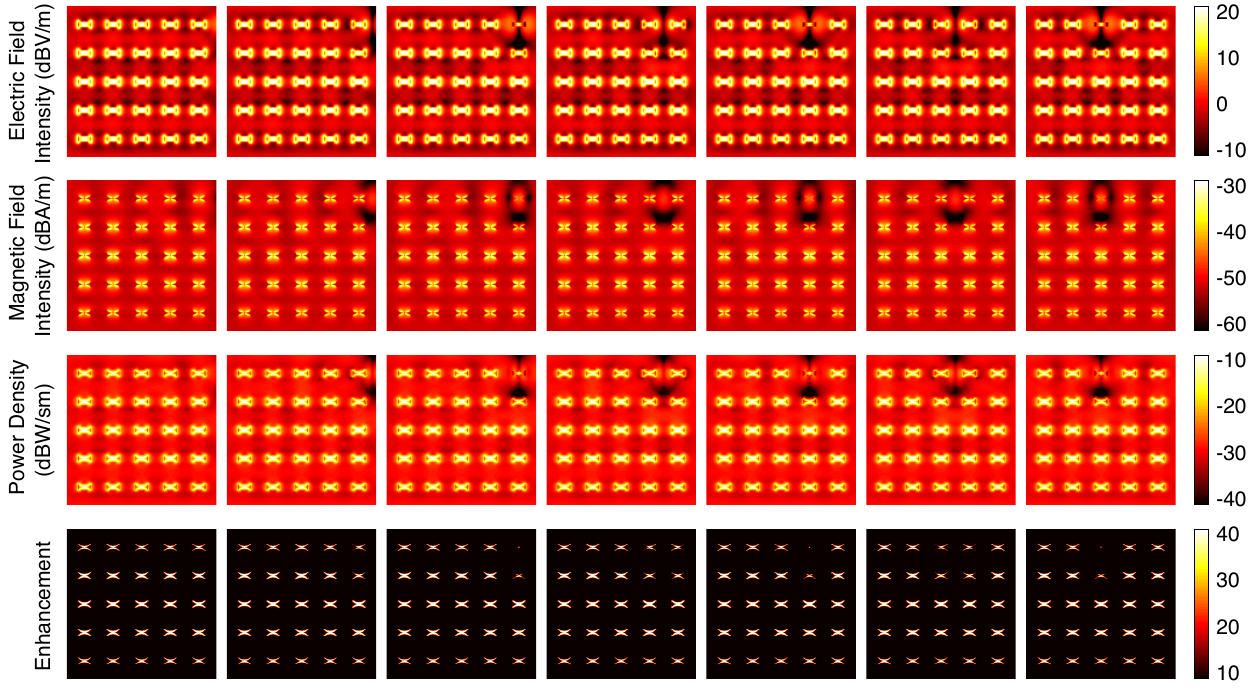
Figure 7: Near-zone characteristics of an array of 5 × 5 nanoantennas when an Ag particle of diameter 600 nm moves above the array as described in Fig. 6(a). The periodicity of the array is 475 nm. The bottom of the particle is 10 nm away from the top surface of the nanoantennas.